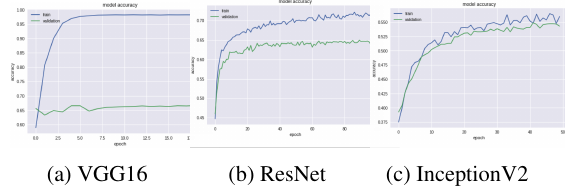
Figure 6. Accuracy for training and validation